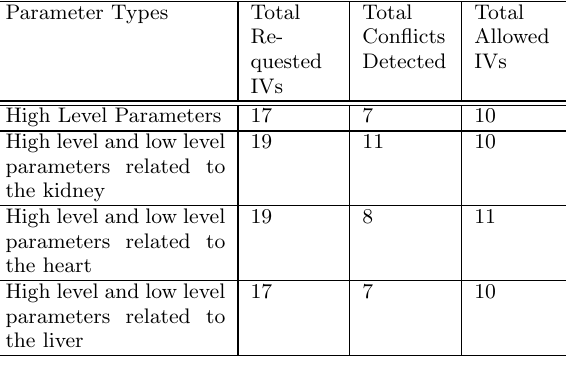
Table 2: Summary of the interventions of 24 hours by focusing the analysis to specific low level